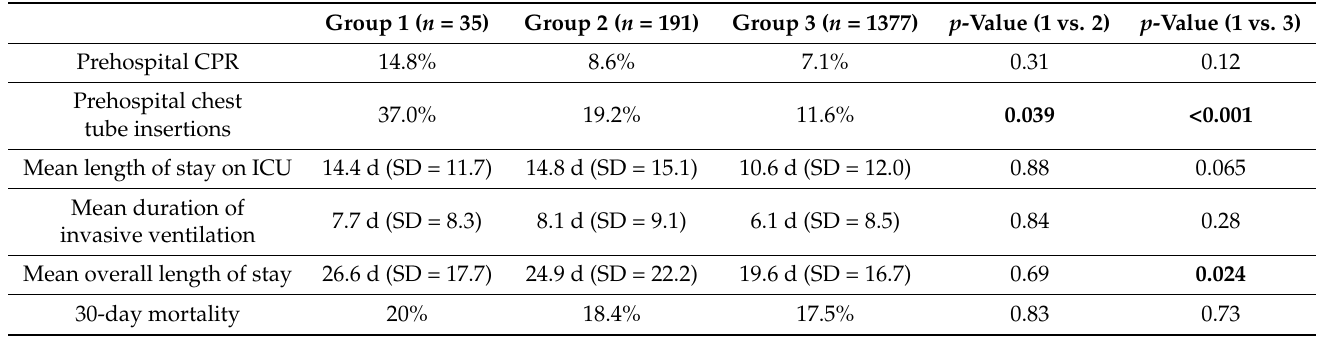
Table 2. Initial treatment and clinical